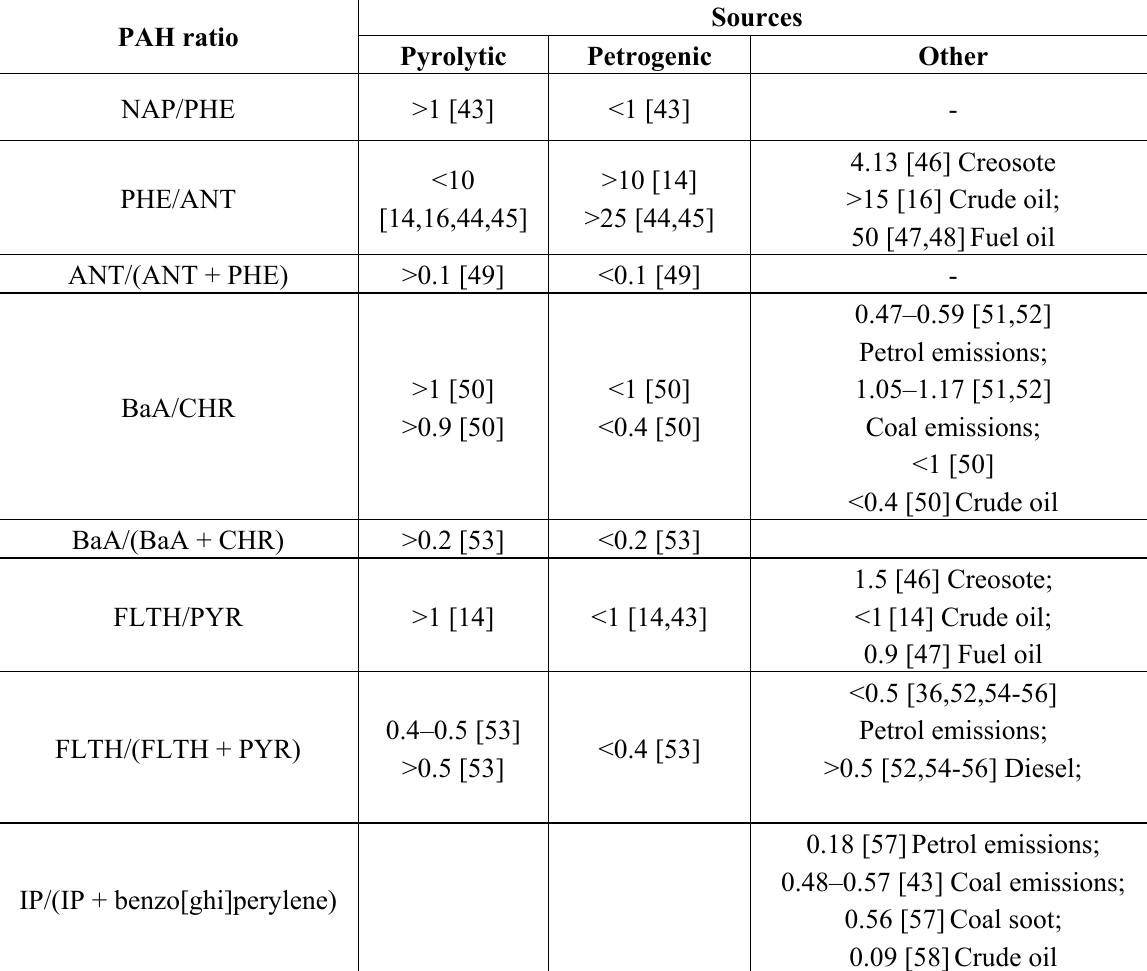
Table 4. Characteristic values of molecular indices for determining the origins of